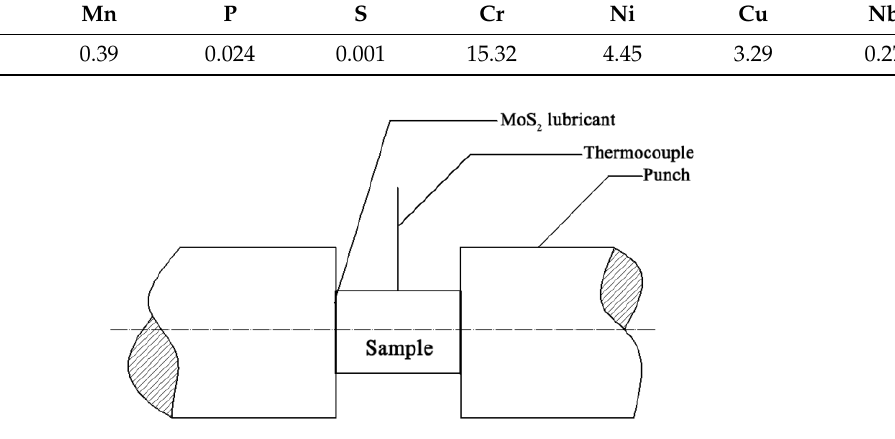
Figure 1. Schematic diagram of the hot compression test.